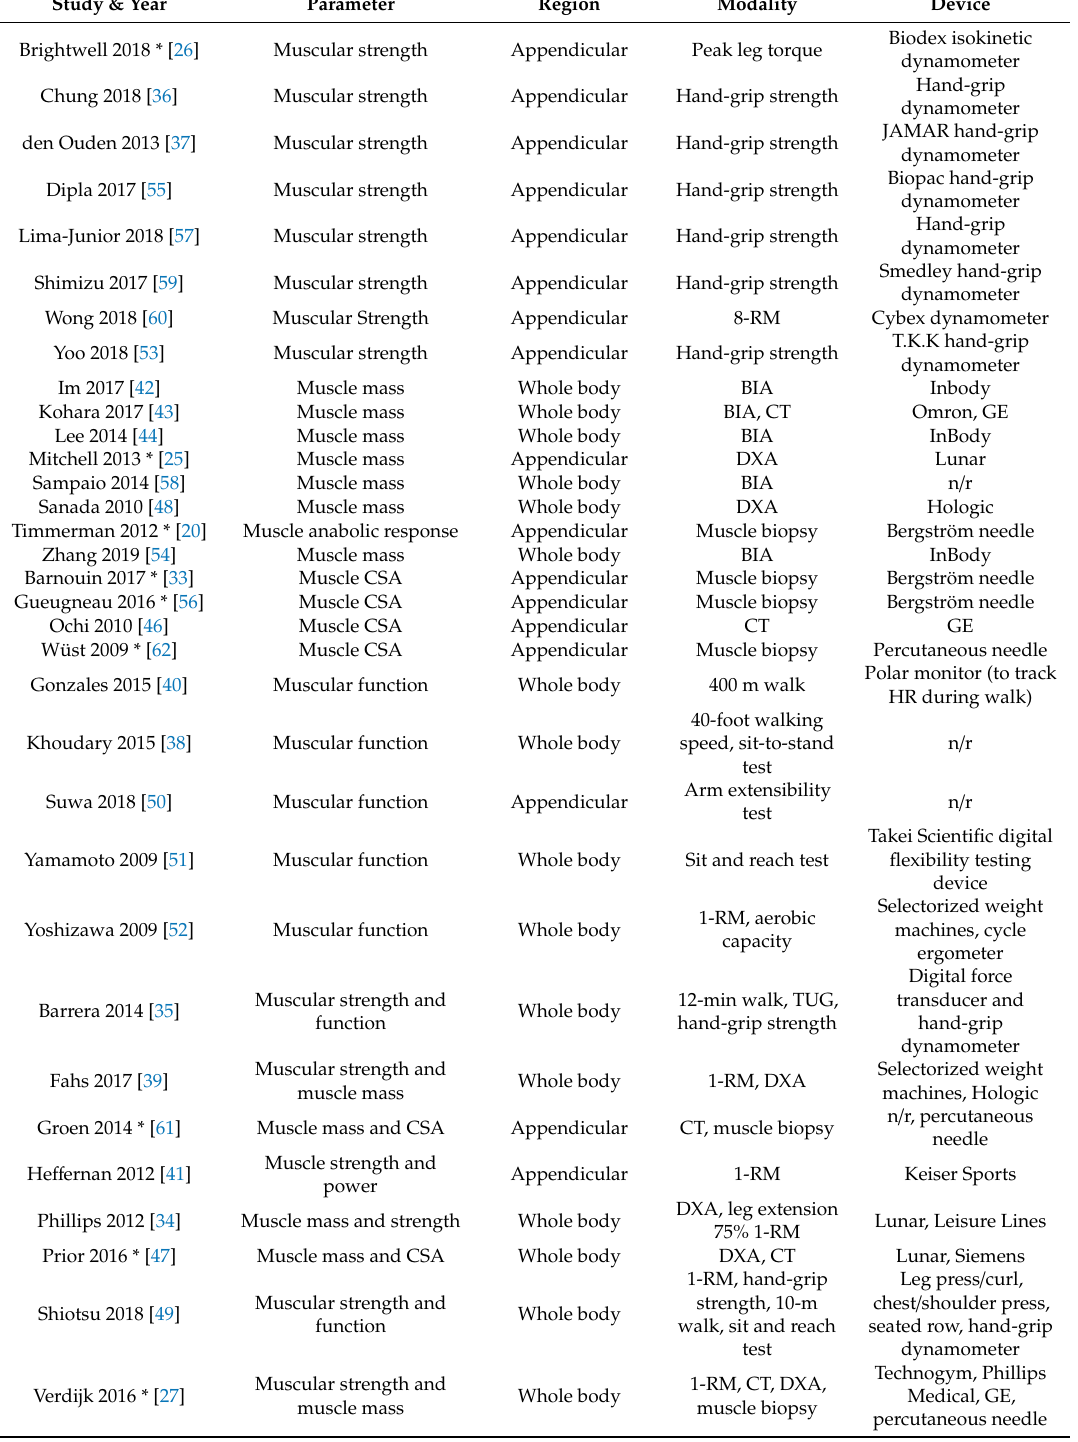
Table 2. Assessment of skeletal muscle